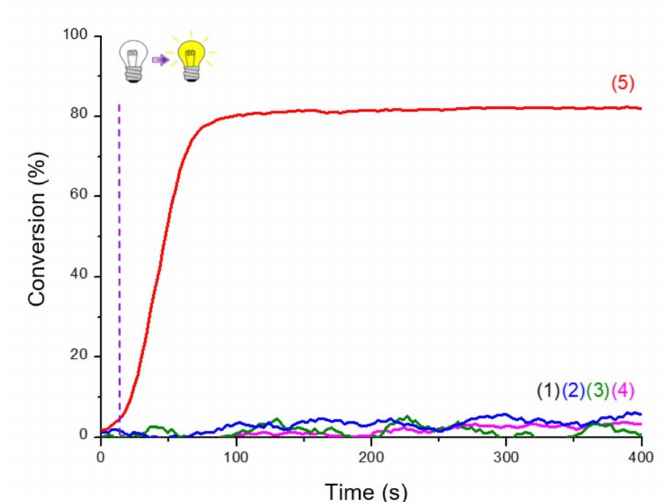
Figure 5. RT-FTIR photopolymerization profiles (C = C conversion of Mix-MA resin vs. irradiation time upon LED@405 nm of (1) the resin Mix-MA alone; (2)–(5) in the presence of Napht-B1: (2) alone in the monomer; in combination with (3) Ar 2 I + PF 6 − (1.5 wt%); (4) 4-dppba (0.5 wt%) and (5) Ar 2 I + PF 6 − (1.5 wt%) and 4-dppba (0.5 wt%); LED@405 nm, thickness = 1.4 mm, under air, irradiation start after 10 s (dot